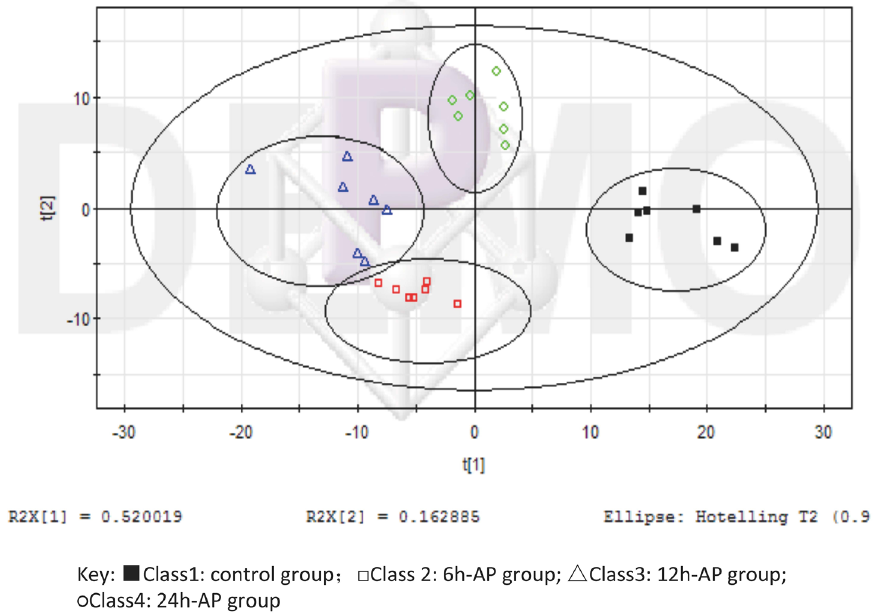
FIGURE 6 - Score plot of the first two values of the proton nuclear magnetic resonance ( 1 H NMR) spectra of serum samples from the control and acute pancreatitis (AP) groups (6-h, 12-h, and